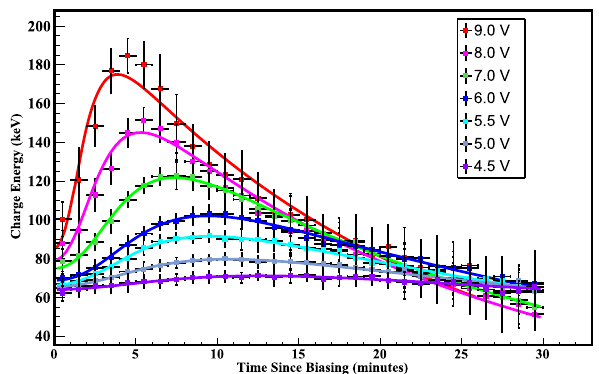
Fig. 6 Shown is the detected charge energy created by impact ioniza- tion as a function of applied bias voltage fitted by Eq. (1) using data from Run 67. The error bars represent the vertical width of the band shown in Fig.4